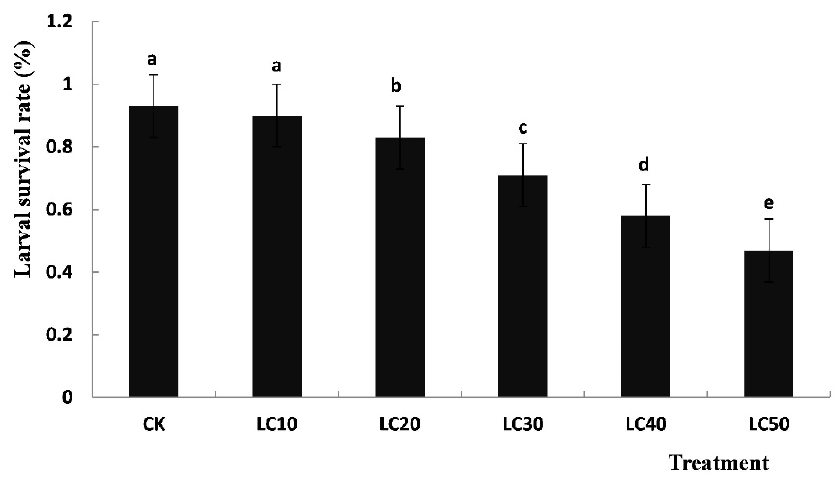
Figure 1. Survival rates of T. cinnabarinus larvae treated with a sublethal concentration of diflubenzuron. Notes: CK served as the control group. The data are expressed as means ± SE of three replicates and subjected to one-way ANOVA followed by Duncan’s multiple range test. Different letters above each bar indicate a statistically significant difference at p < 0.05; same lowercase letters indicate non-significant changes.